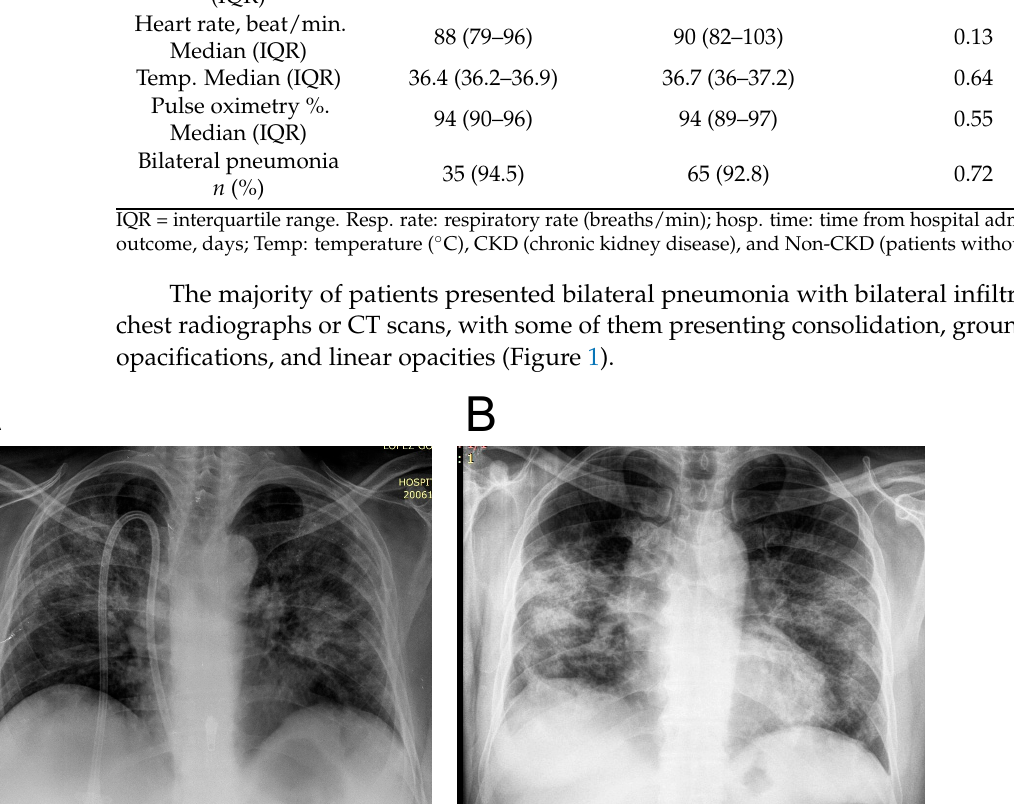
Figure 1. Representative chest X ray images from two patients (( A ) CKD: chronic kidney disease and ( B ) Non-CKD: patients without CKD) admitted with the diagnosis of severe acute respiratory syndrome coronavirus disease 2019 (SARS-COVID-19) both patients presented with bilateral infiltrates and ground-glass opacifications.